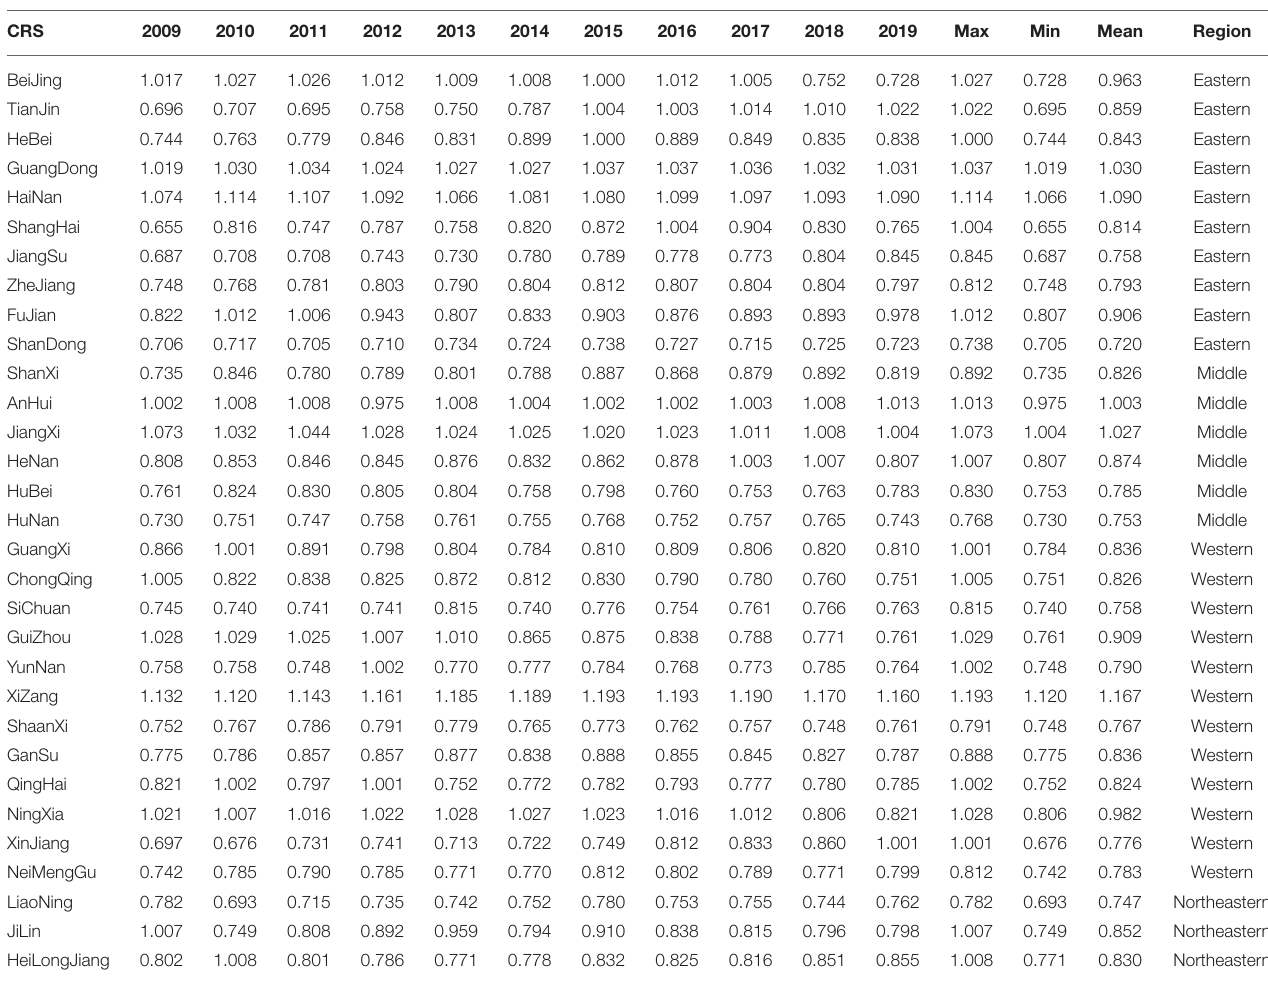
TABLE 3 | Health production efficiency in China